Question: Express in one sentence what the figure is showing.
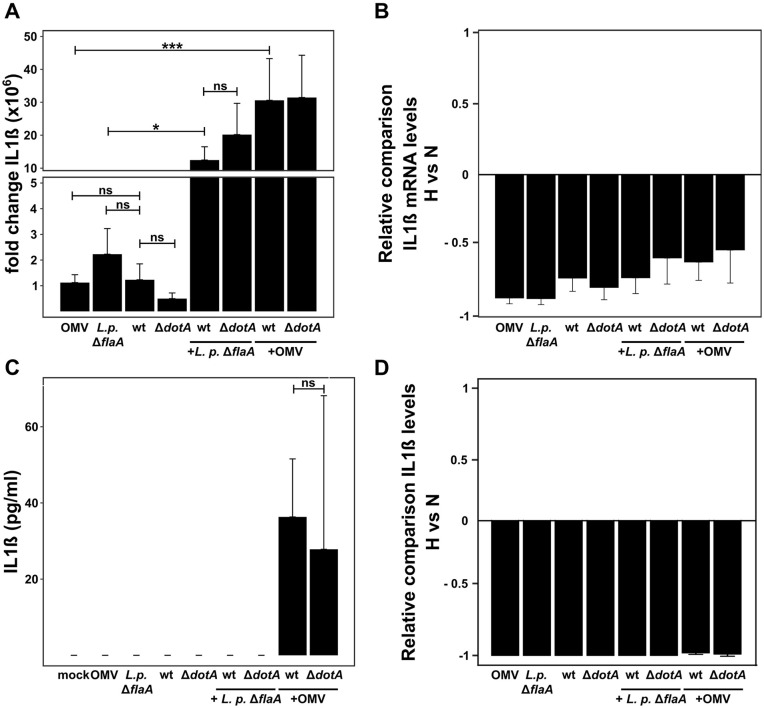
Answer: Transcription and secretion of IL1β is reduced under hypoxic conditions. BMDM were stimulated with OMVs (2 µg/ml) for 8h, infected with L. pneumophila Δ flaA for 8h, infected with C. burnetii wt or Δ dotA for 32h or infected with C. burnetii wt or Δ dotA for 24h with subsequent infection with L. pneumophila Δ flaA or stimulation with OMVs for 8h under hypoxic conditions (0.5% O 2 ). (A) Fold change of the IL1β mRNA transcript levels relative to uninfected BMDM were quantified by RT-qPCR. Mean ± SD, n = 3, One-Way-ANOVA with Bonferroni post-test. (B) Relative comparison of the IL1β mRNA transcript level under hypoxic condition (0.5% O 2 ) versus normoxic condition (21% O 2 ). [Relative comparison = (fold change IL1β under hypoxia ( Fig 4A ) - fold change IL1β under normoxia ( Fig 2A )): fold change IL1β under normoxia ( Fig 2A )] (C) IL1β secretion was determined by ELISA. Mean ± SD, n = 3, Mann-Whitney U test. *p < 0.05, ***p < 0.001. (D) Relative comparison of secreted IL1β (pg/ml) under hypoxic condition (0.5% O 2 ) versus normoxic condition (21% O 2 ). [Relative comparison = (secreted IL1β (pg/ml) under hypoxia ( Fig 4C ) - secreted IL1β (pg/ml) under normoxia ( Fig 2B )): secreted IL1β (pg/ml) under normoxia ( Fig 2B )].